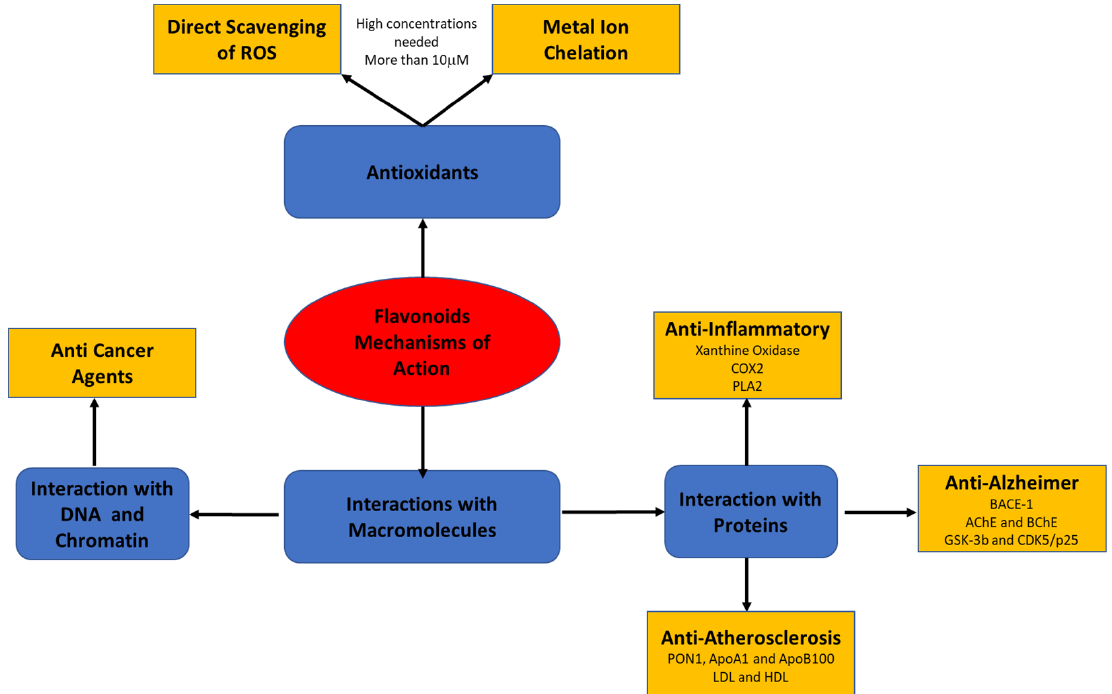
Figure 2. Flavonoids’ mode of action through their interaction with macromolecules.